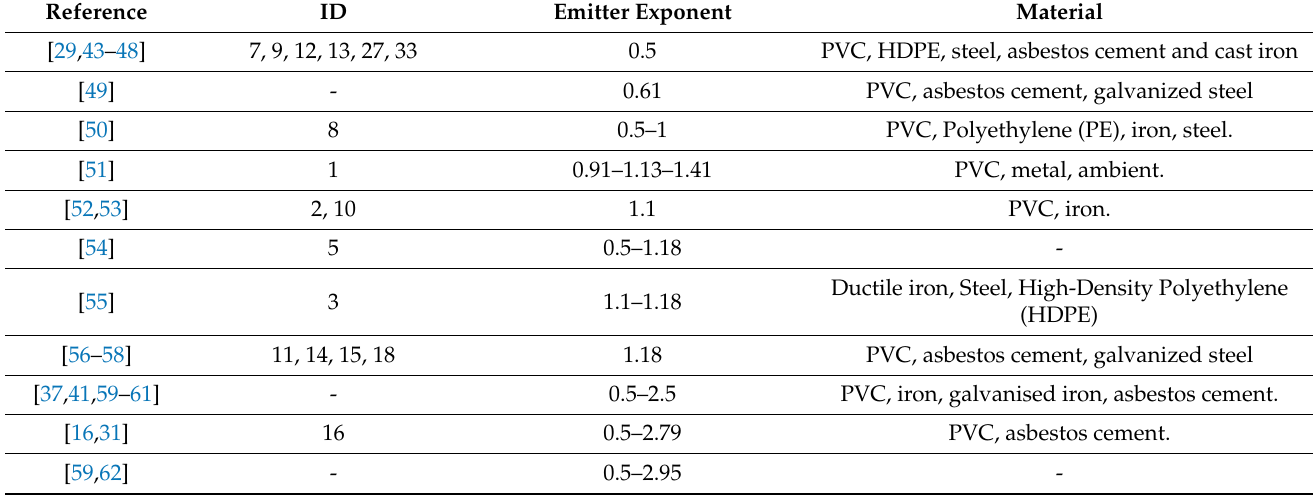
Table 2. Case study emitter